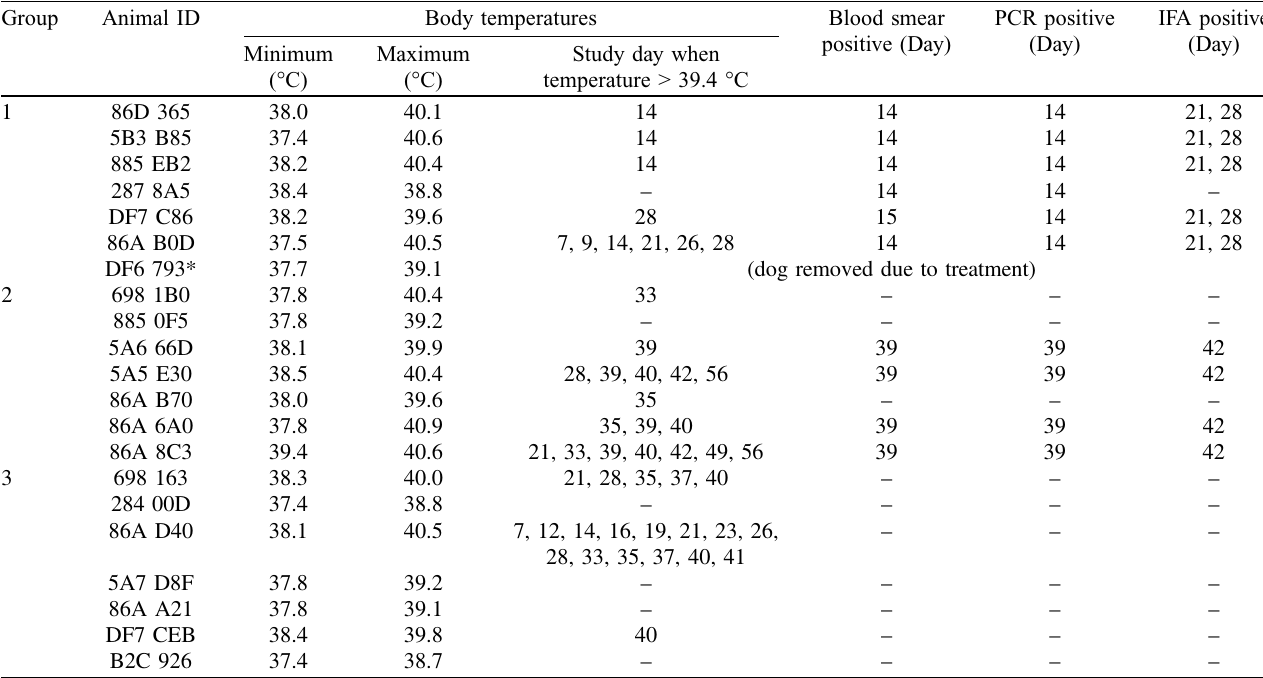
Table 4. Summary of body temperatures, blood smear analysis, IFA and PCR performed during the study. Group Animal ID Body temperatures